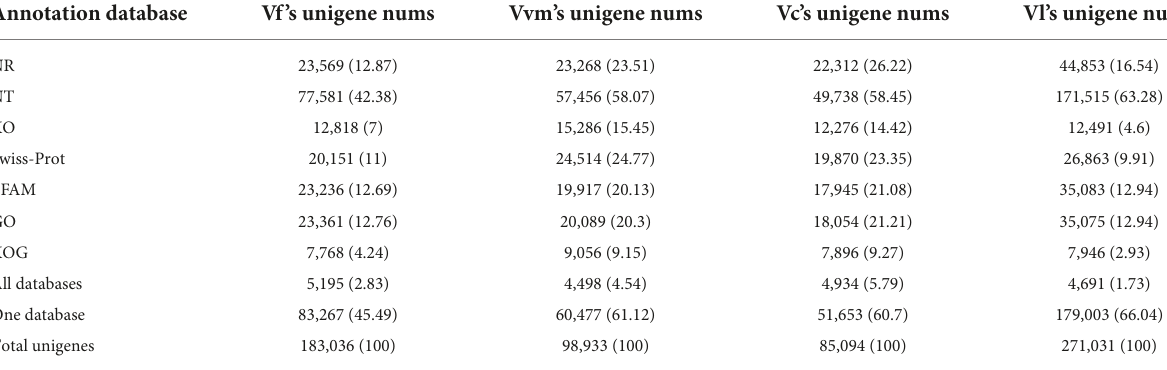
TABLE 2 The result of function annotation based on seven public